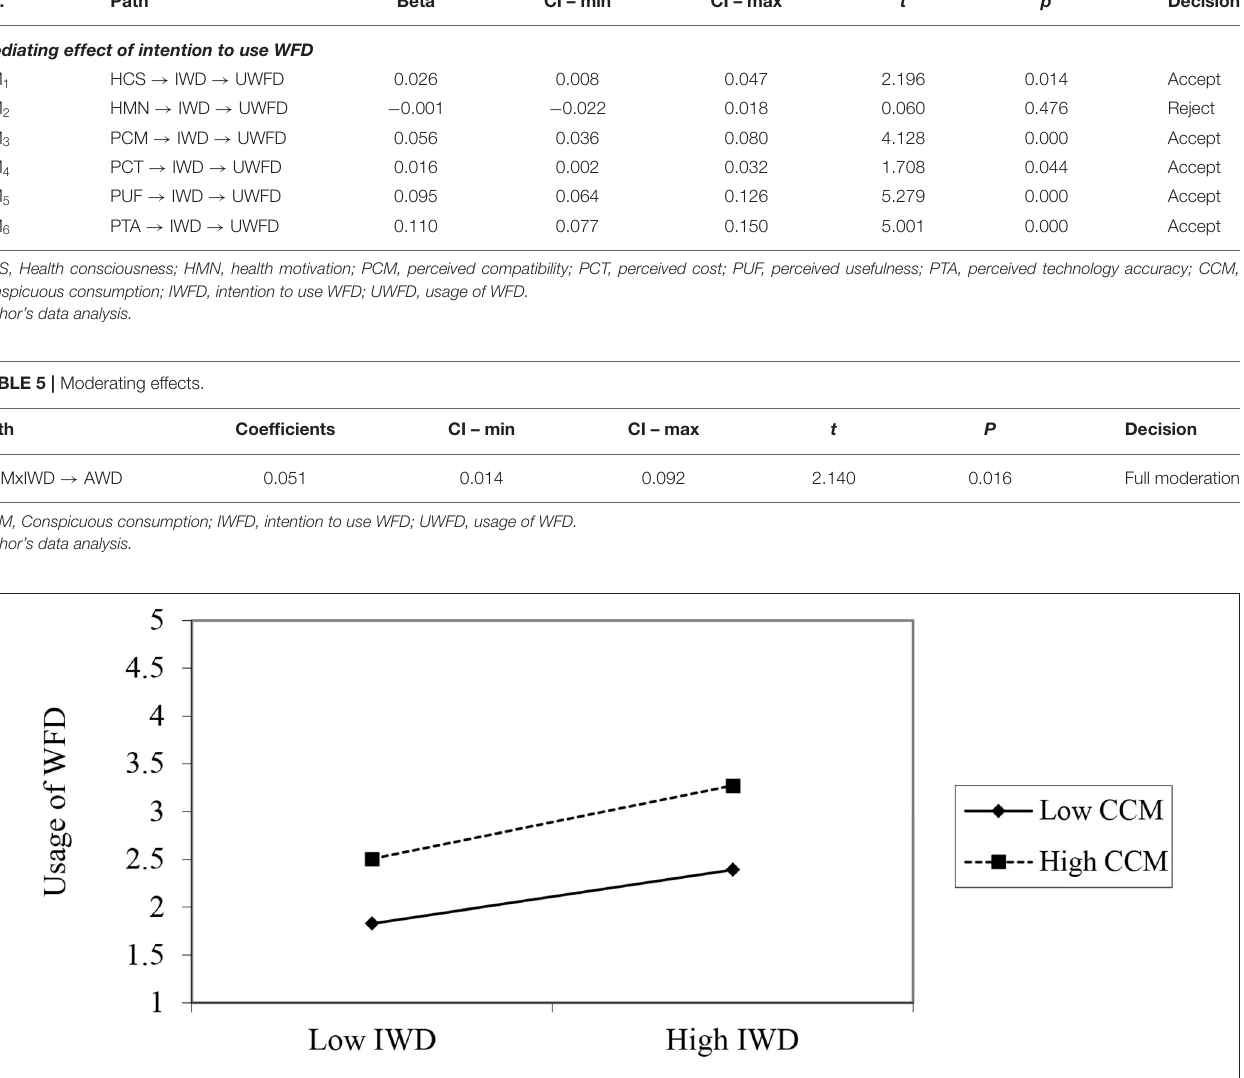
FIGURE 3 | Moderating